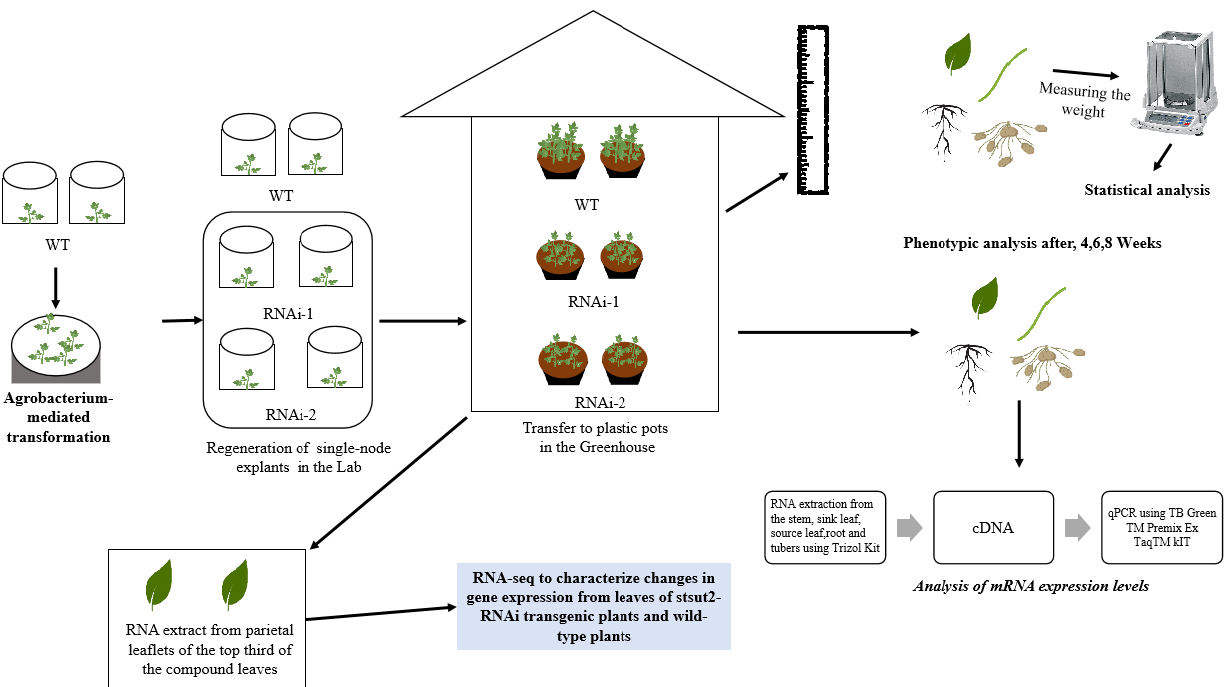
Figure 1. An illustration of the summarized experimental procedure used to analyze potato RNAi- plants.